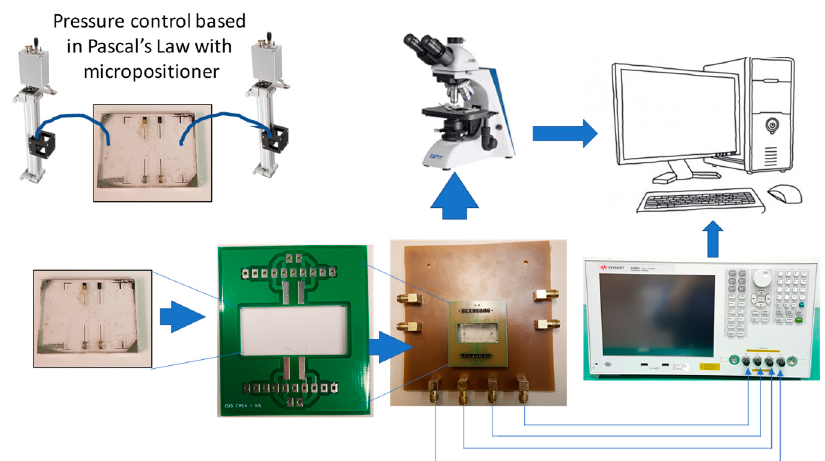
Figure 13. Schematic of the measurement setup.